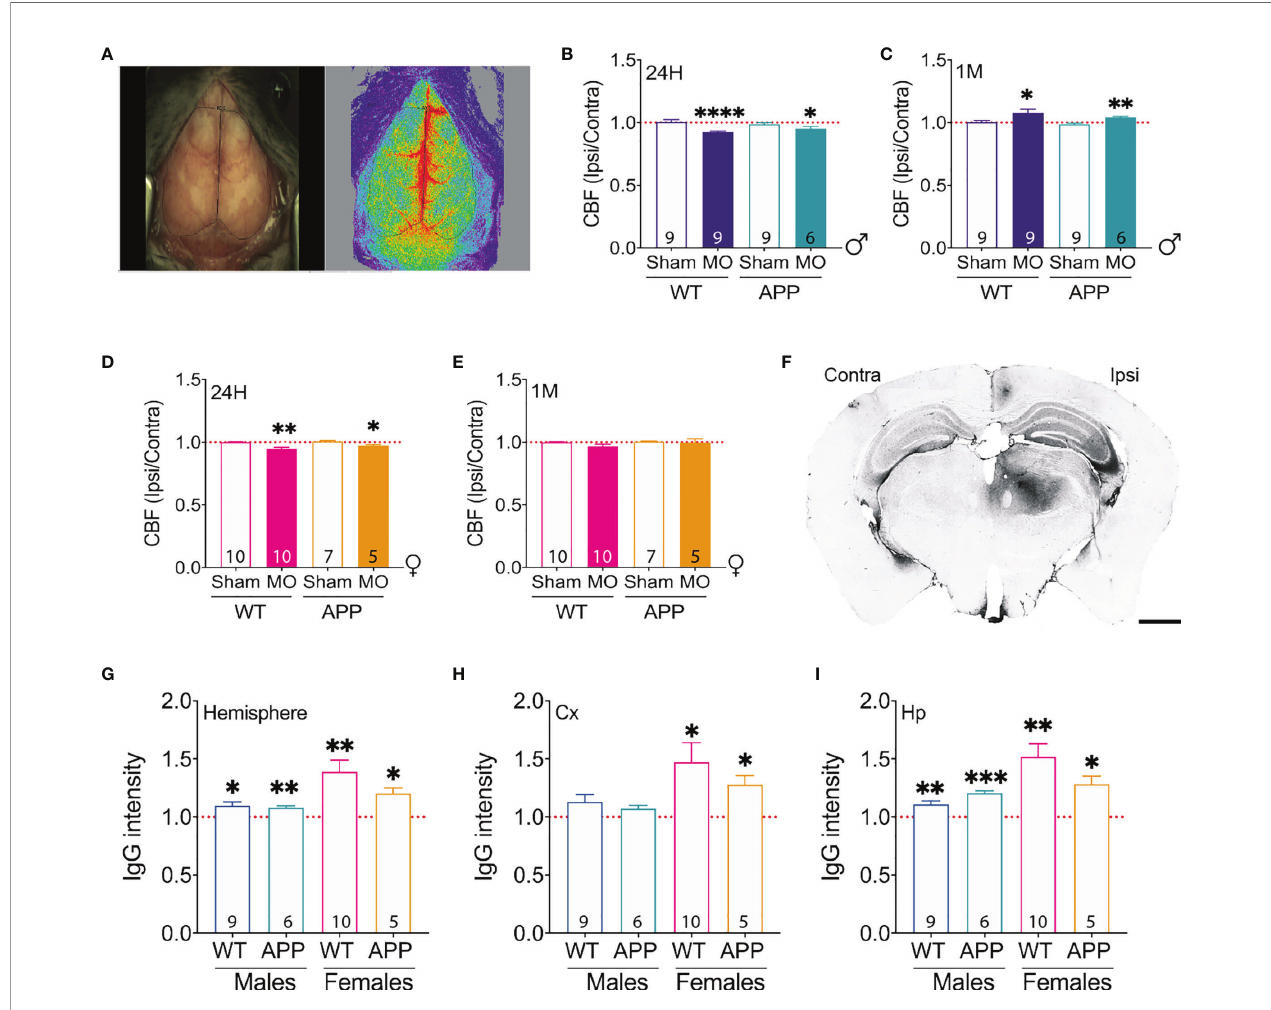
FIGURE 4 | Induction of multifocal microinfarcts is associated with prolonged cerebrovascular dysfunctions. (A) Representative images of the LCSI system used to investigate the CBF. Ratio of the CBF in the ipsilateral hemisphere over the contralateral hemisphere was computed and analyzed. LCSI analysis shows that the CBF (B) decreases in the ipsilateral hemisphere 24 hours post-microinfarct induction, while (C) it increases 1 month later in MO-operated male WT and MO-operated male APP/PS1. In females, LCSI analysis shows that the CBF (D) decreases in the ipsilateral hemisphere 24 hours post-microinfarct induction, and (E) is restored 1 month later in MO-operated female WT and MO-operated female APP/PS1. A representative image of (F) IgG immunolabeling indicative of extravasation in the brain of MO-operated male WT mice. Analysis of IgG immunolabeling in the overall hemisphere (G) indicates that IgG in fi ltration is increased in the ipsilateral hemisphere of MO-operated male and female WT as well as APP/PS1 mice. Analysis of IgG speci fi c immunolabeling in the cortex (H) indicates that IgG in fi ltration remains unchanged among MO-operated male APP/PS1 mice and MO-operated male WT mice, whereas it similarly increases in the ipsilateral cortex of MO-operated female WT mice and MO-operated female WT mice. Analysis of IgG immunolabeling in the hippocampus (I) indicates that IgG in fi ltration increases in the ipsilateral hippocampus of MO-operated male and female WT as well as APP/PS1 mice. Data are mean ± SEM (n = 5-10 animals/group). *P < 0.05/**P < 0.01/****P < 0.0001 compared to 1 (one sample t-test) for the CBF and IgG ratios. Scale bar = 1000